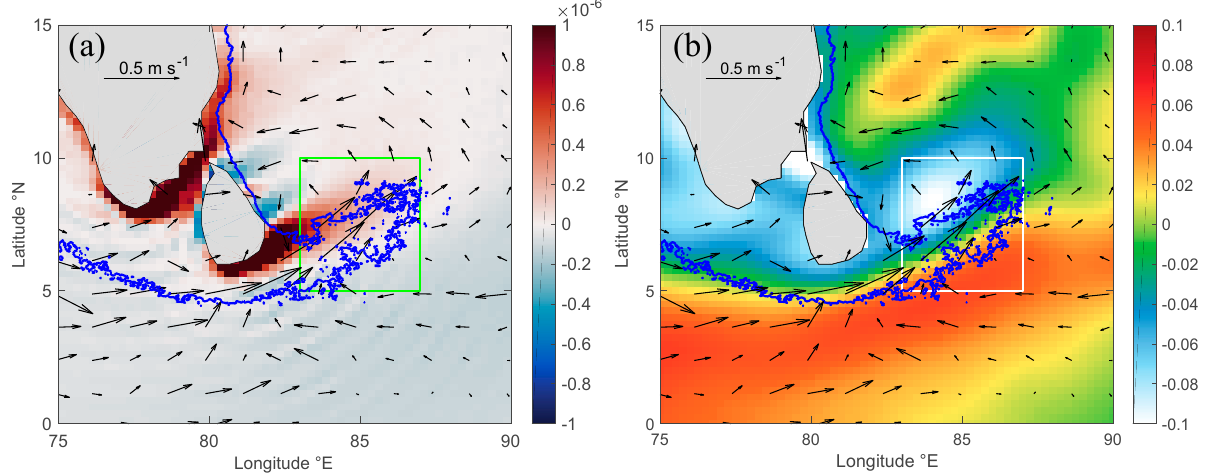
Figure 4. ( a ) Wind stress curl (units: N m − 3 ) and ( b ) sea surface height anomaly (SSHA) (units: m) during the SW monsoon (June–September). Arrows are geostrophic currents derived from the altimetry data. The green and white boxes denote the region of SLD. Blue contours denote the chlorophyll concentration of 0.35 mg m − 3 in Figure 2b.